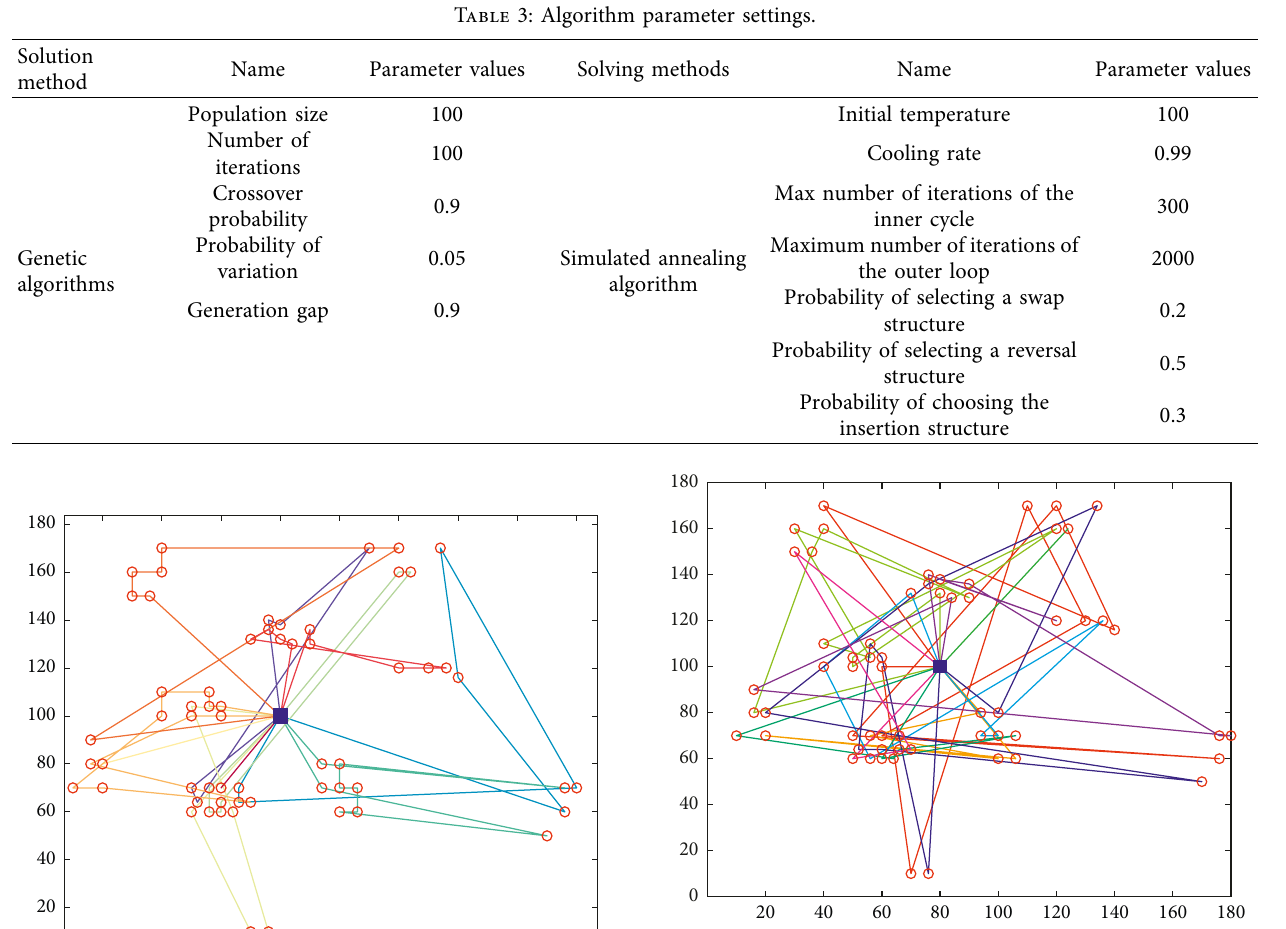
Figure 8: Optimal route for the simulated annealing algorithm.